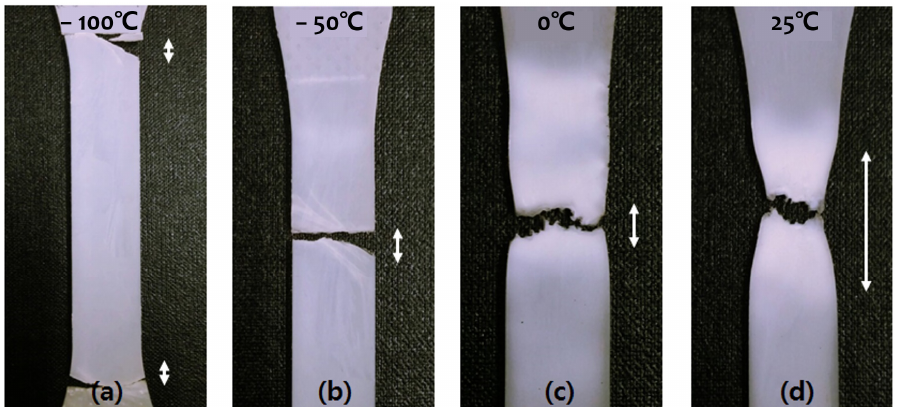
Figure 3. Temperature-dependent stress-strain curves of the polymers: ( a ) PVDF, ( b ) PE, and ( c ) ABS.